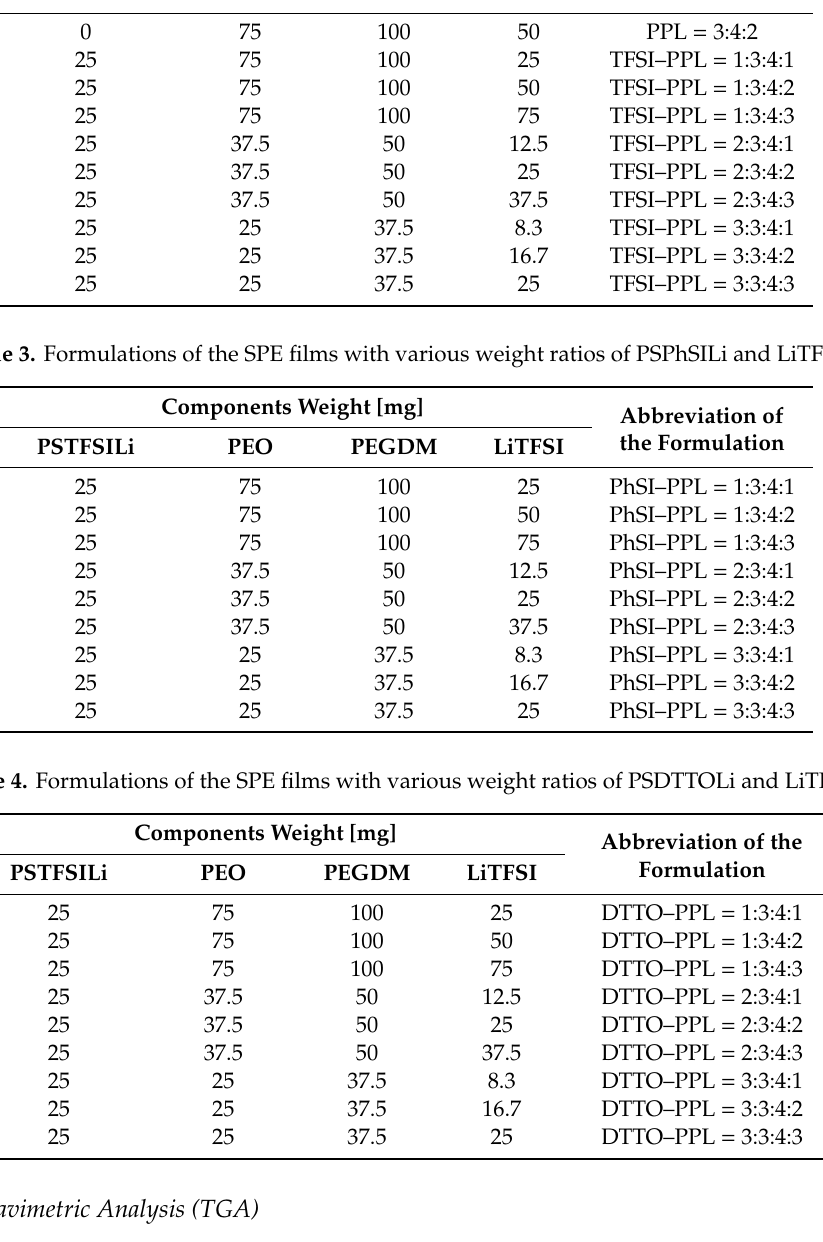
Table 2. Formulations of the SPE films with various weight ratios of PSTFSILi and LiTFSI. Components Weight [mg] Abbreviation of